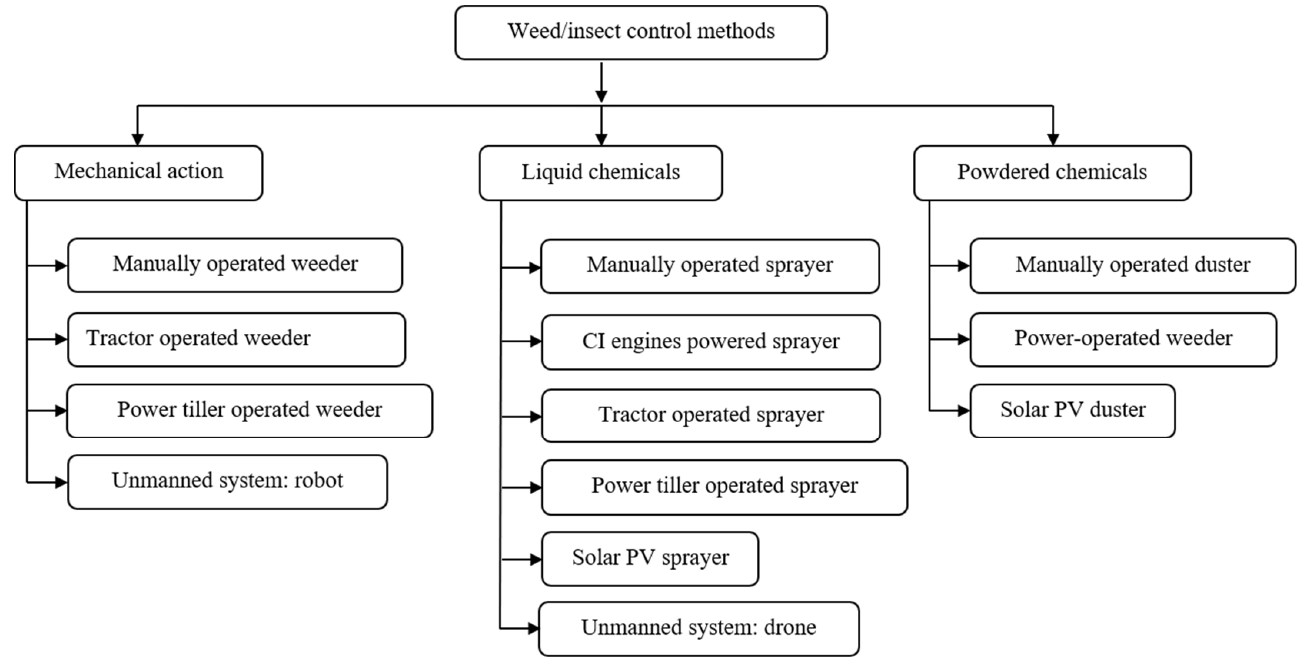
Figure 1. Different weed/insect control methods used in agriculture.